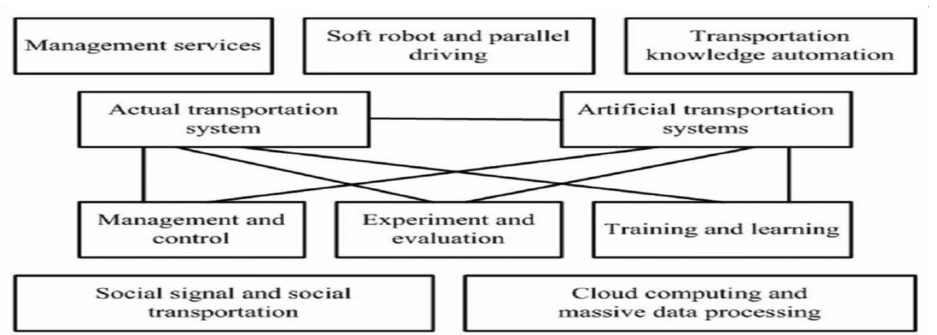
Figure 7. ACP smart transportation architecture